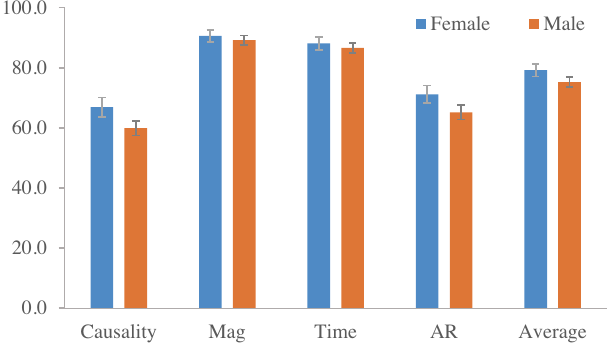
FIG. 3. Average percentages of correct answers on the four attributes of causal reasoning from male and female high school students. The error bars reflect the standard errors.